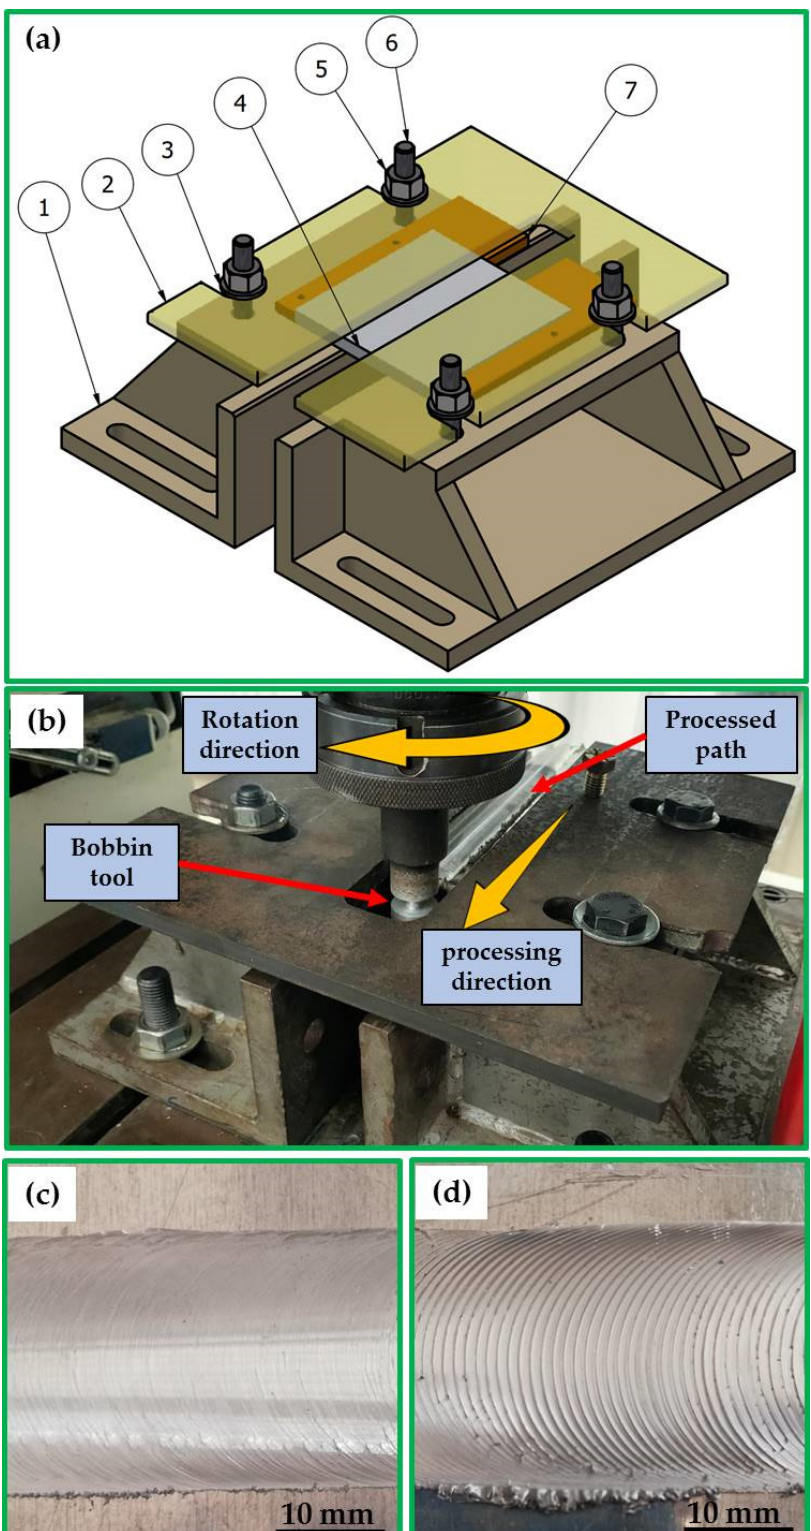
Figure 1. ( a ) Three-dimensional drawing of the fixture setup, (1) fixture base, (2) covering plate, (3) washer, (4) AA1050 plate, (5) nut, (6) bolt, and (7) fixation plate; ( b ) photo image of the BT-FSP of AA1050, ( c ) and ( d ) the top surfaces of the processed specimens at traveled speeds of 100 and 300 mm/min, respectively, using the Cy pin geometry.